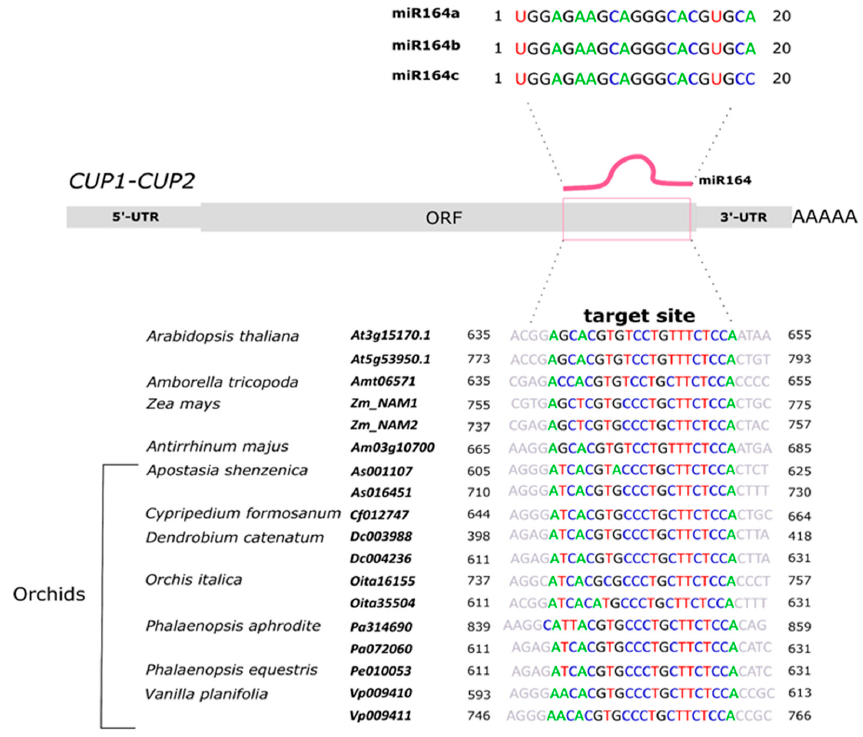
Figure 6. The miR164 target site on the CUP transcripts of orchid and non-orchid species.